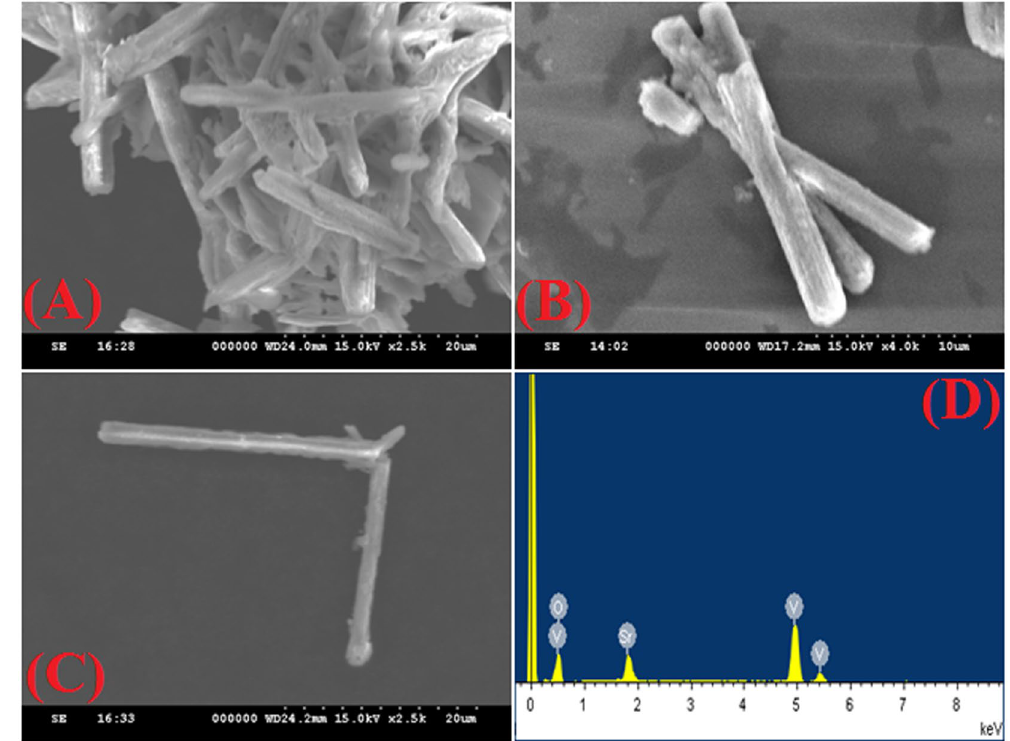
Figure 2. SEM images of SrV 2 O 6 at different magnification 20 µ m ( A-C ) 10 µ m ( B ) and corresponding to EDX spectrum of SrV